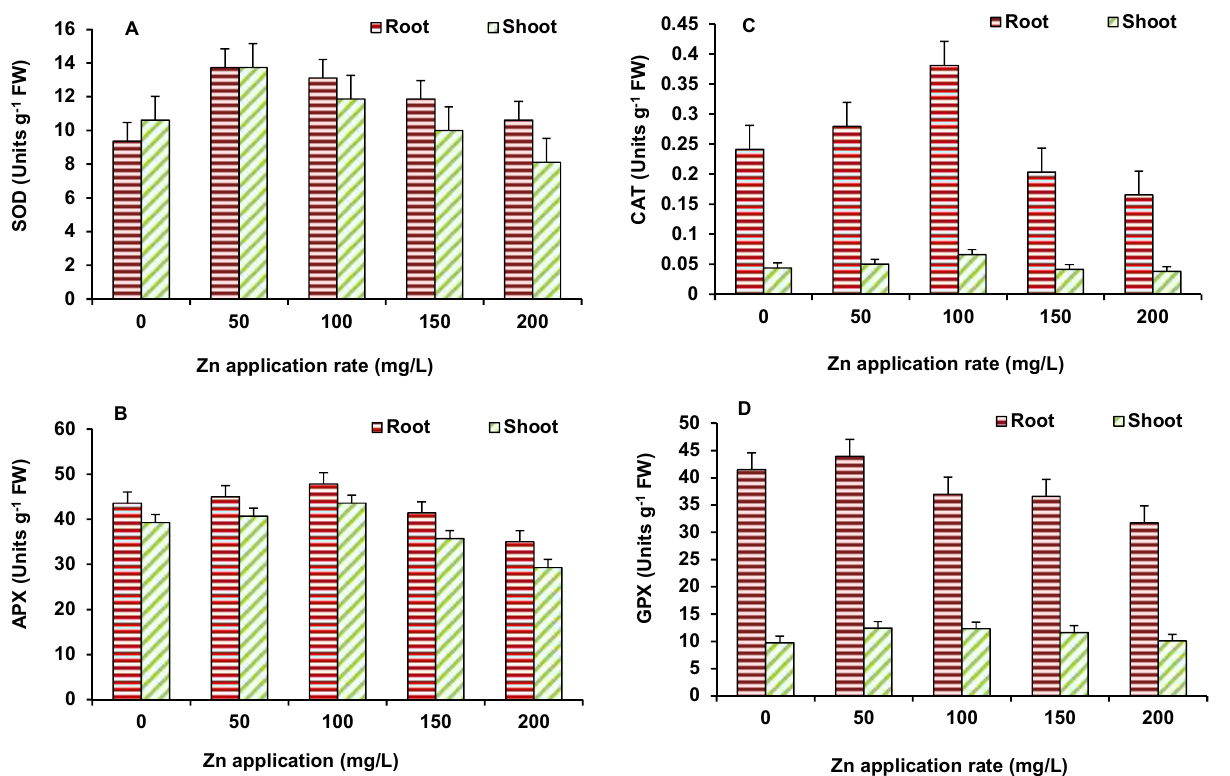
Figure 7. Effect of ZnO NP treatment on activity of SOD ( A ), APX ( B ), CAT ( C ), and GPX ( D ) of maize. Values are means of four replicates. Error bars indicate the least significant value (LSD) at p ≤ 0.05 among the treatments.